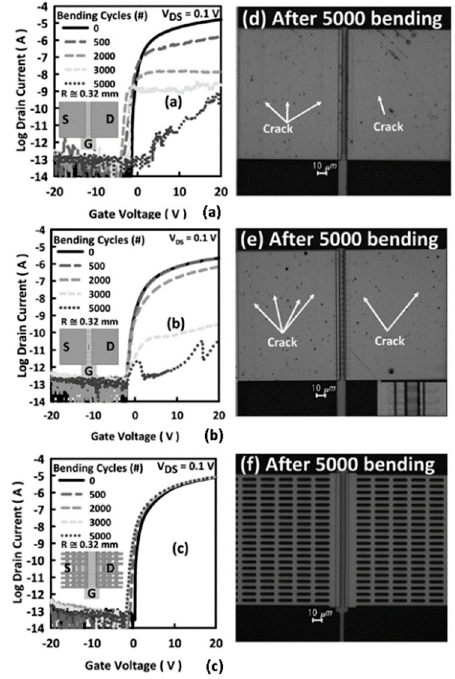
Figure 16. Three kinds of flexible TFTs for bending tests. Transfer curves and optical images of a-IGZO TFTs with ( a,d ) conventional structure with block electrode shape, ( b,e ) conventional block electrode shape and strip semiconductor layer shape, and ( c,f ) metal mesh electrode shape [181].